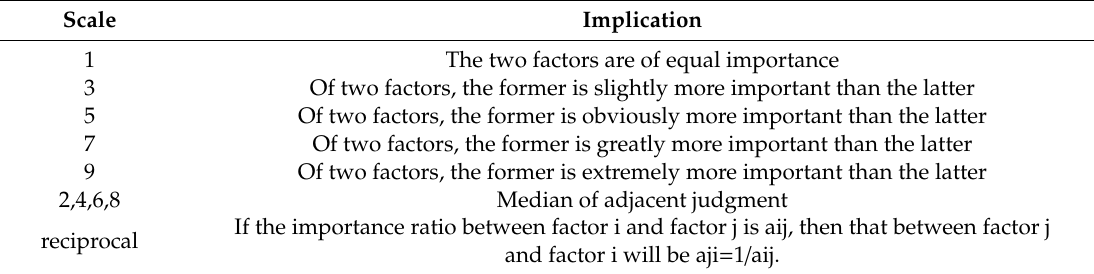
Table 3. aij Value Size, Scale and